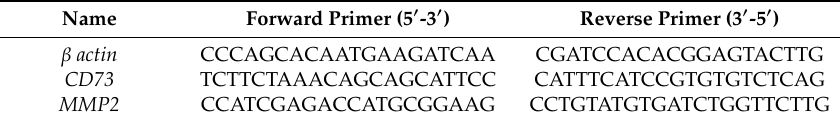
Table 1. Primer sequences used in RT